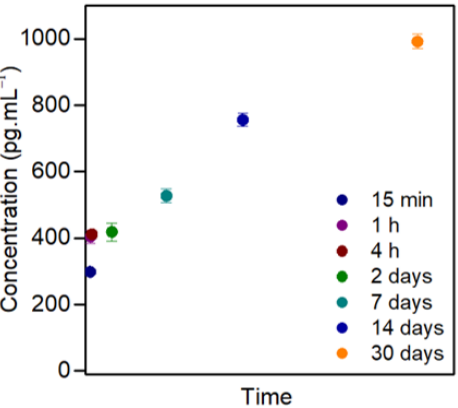
Figure 4. GDNF release profile from CMCht/PAMAM NPs quantified by ELISA at 15 min, 1 and 4 h, and 2, 7, 14 and 30 days. Quantitative data are presented as mean and error bars ( n = 3).